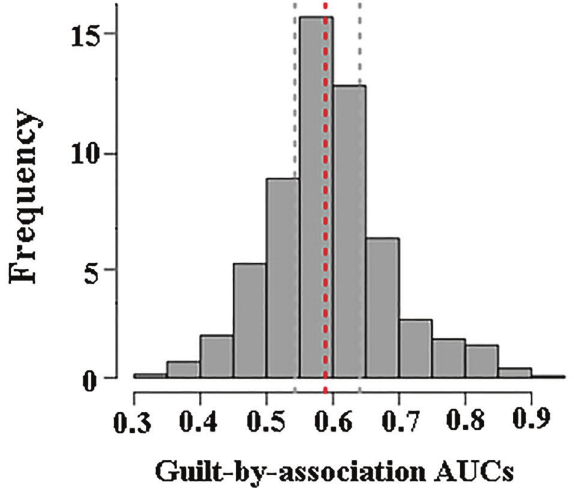
Figure 4. Gene function prediction by means of guilt by associa- tion method based on area under the curve (AUC) values. The histogram shows AUCs across all gene oncology categories, which were identi fi ed relying on a single list constructed from the count of co-expression